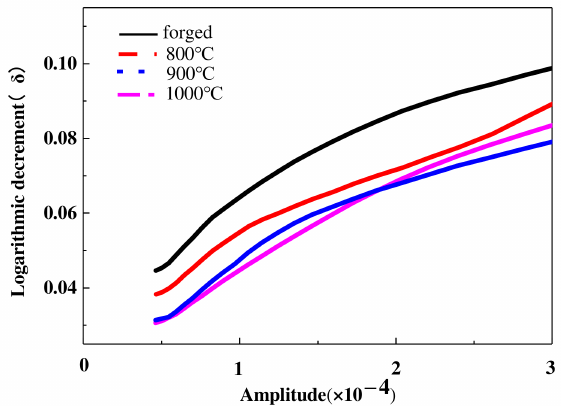
Figure 5. The influence law of annealing temperature on the damping performance of Fe-22Mn-12Cr- 4Co-0.2Nb-0.02C alloy.